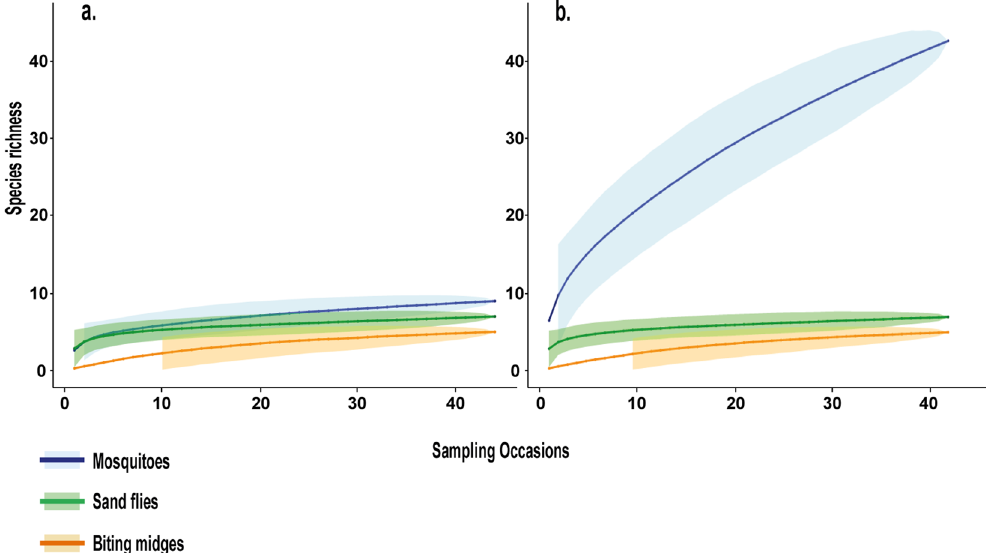
Figure 2. Species accumulation curves for mosquitoes, sand flies and biting midges relative to the number of sampling events in Kessipoughou ( a ) and Djibilong ( b ) caves. Curves show the cumulated species richness (S values) of Diptera groups according to sampling events. Sampling representativeness seemed good for each insect group in both caves, with the exception of mosquitoes in Djibilong. The lack of representativeness for the mosquito community inside Djibilong cave was confirmed by the important number of estimated non-sampled species ( NS = 13.1, Table 1), extrapolated from the Chao